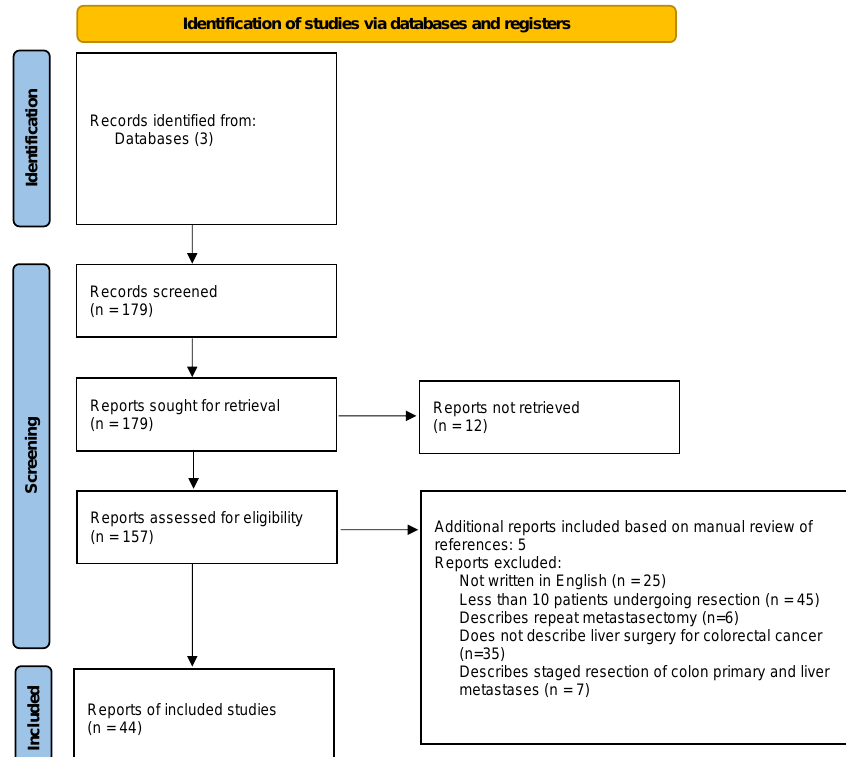
Figure 1: Flow diagram